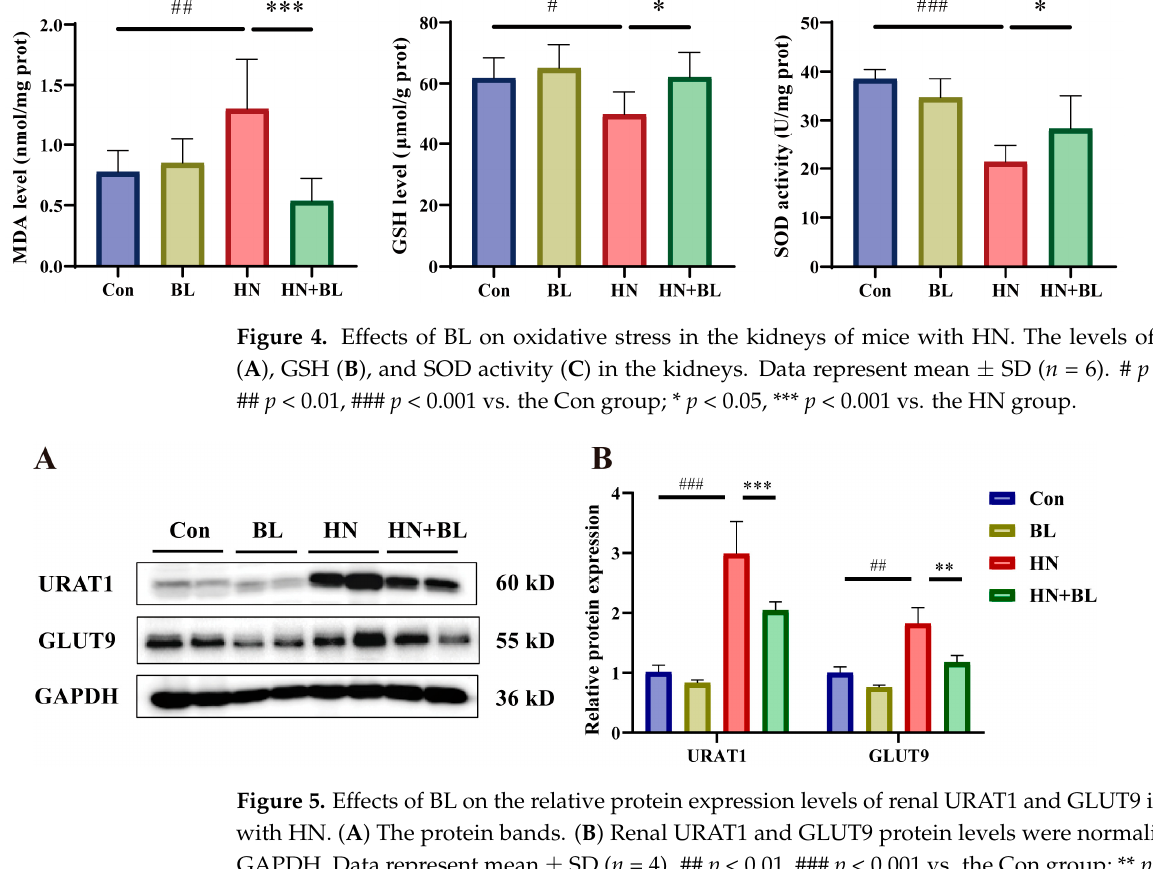
Figure 5. Effects of BL on the relative protein expression levels of renal URAT1 and GLUT9 in mice with HN. ( A ) The protein bands. ( B ) Renal URAT1 and GLUT9 protein levels were normalized to GAPDH. Data represent mean ± SD ( n = 4). ## p < 0.01, ### p < 0.001 vs. the Con group; ** p < 0.01, *** p < 0.001, vs. the HN group.